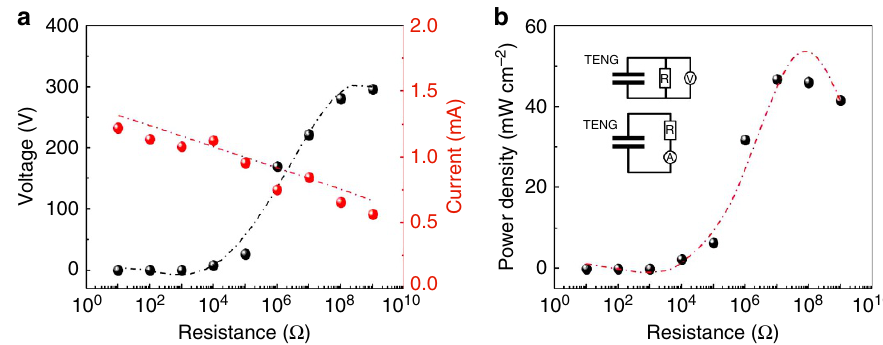
Figure 5 | Output power of three-layer structured triboelectric nanogenerator and power density on the surface. ( a ) The output voltage and current and ( b ) the output power of three-layer structured TENGs with the resistance of external loads from 10 to 10 9 O .